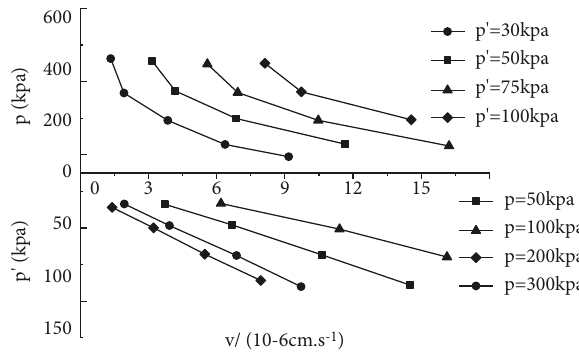
Figure 2: V-p-p’ relationship under different loading